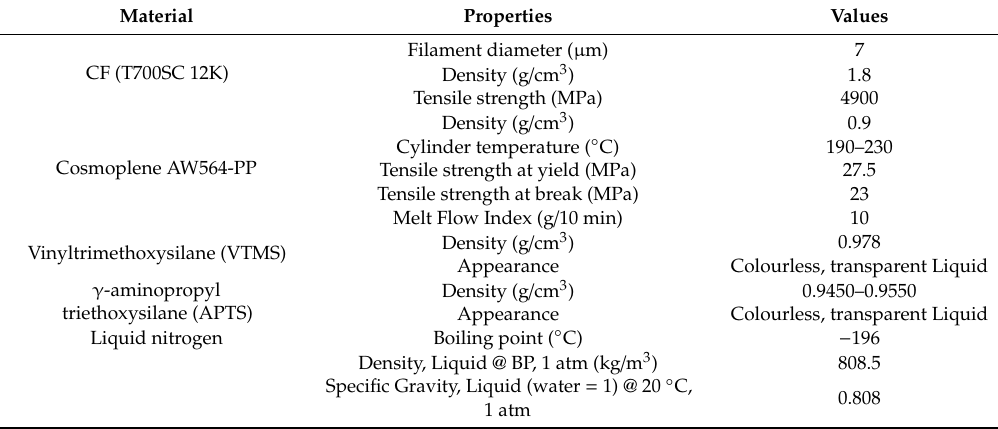
Table 1. Material